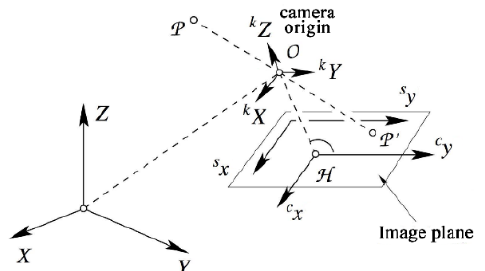
Figure 2 . Scheme of the coordinate reference systems involved in the projection process. Letters (XYZ) denote the object reference system; ( k X k Y k Z) is the camera reference system; ( c x c y) is the image coordinate system and ( s x s y) is the sensor reference system (image adapted from Förstner et al.,